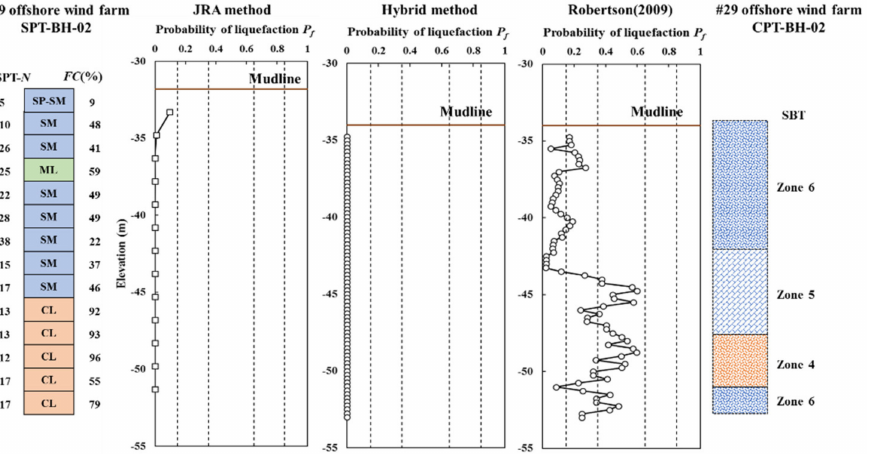
Figure 16. The probability of liquefaction of boreholes CPT-BH-02 and SPT-BH-02 in #29 offshore wind